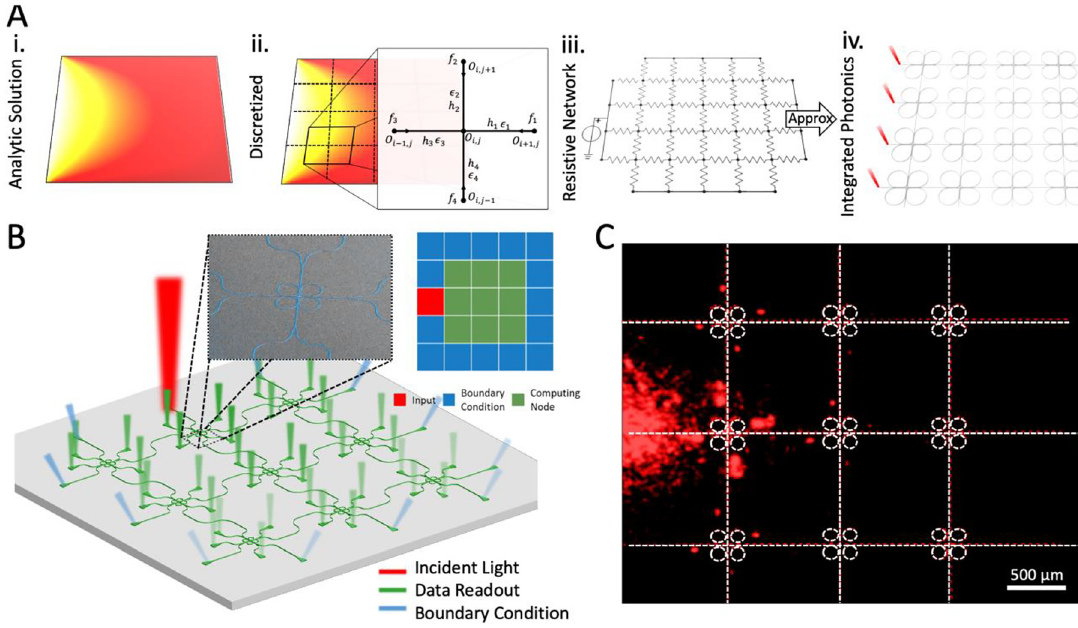
Figure 3: Solving PDE using Kirchhoff ’ s law in integrated photonics. (A) i. Analytic solution of a partial differential equation for the de fi ned boundary conditions. ii . The discretized solution of the same PDE using numericalmethods( fi nitedifference).Thesuperimposedmeshdenotesthediscretization.Insethighlightsthenodeofamesh(notationisthe sameasFigure2). iii. Characteristicelectricalresistormeshwhichmapsthe fi nitedifferencemethodappliedtothePDE. iv.